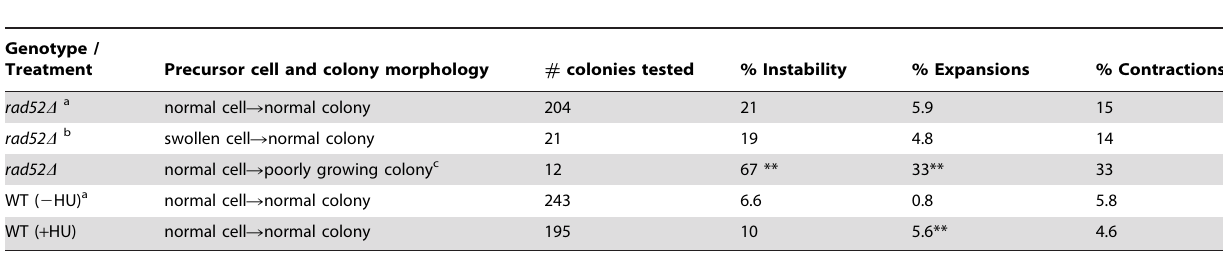
Table 2. CAG-70 repeat instability in colonies exhibiting poor growth due to frequent arrests or treated with 0.1 M hydroxyurea.